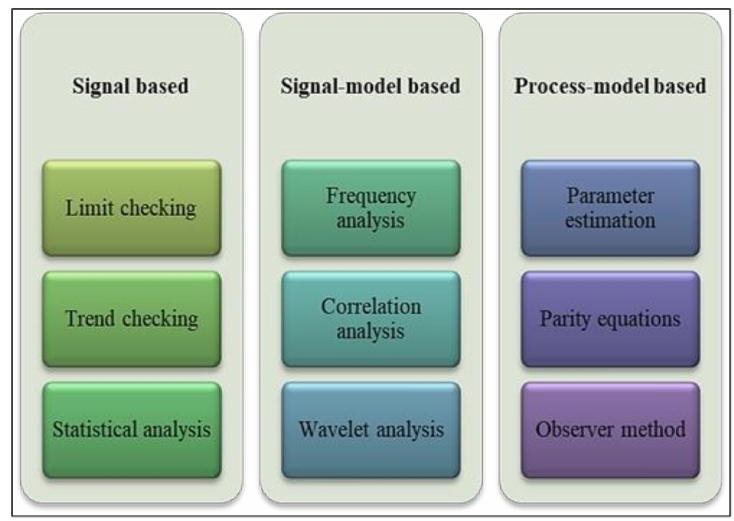
Figure 6. Classification of conventional fault detection